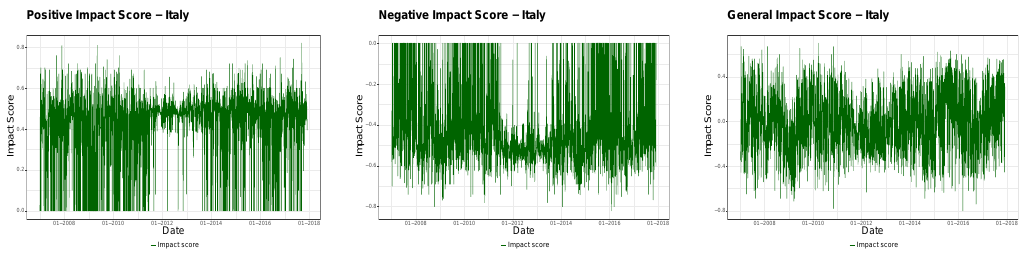
Figure 8. Positive, negative and general news impact scores for Italy between 2007 and